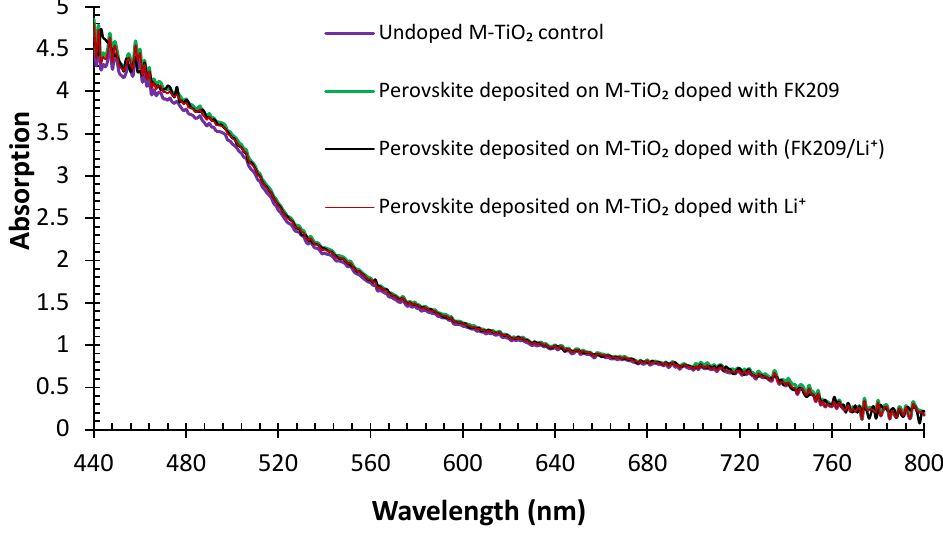
Figure 6. Absorption of perovskite film deposited on M-TiO 2 doped with FK209, FK209/Li + and lithium.